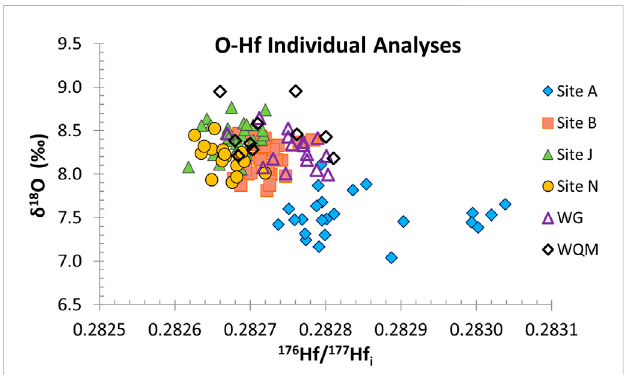
FIGURE 6 The paired δ 18 O and 176 Hf/ 177 Hf data of the zircons from sample Sites A, B, J and N of the Middledale Gabbroic Diorite and from the Woodlands Granite (WG) and the Windover Quartz Monzodiorite (WQM). It is clear that some correlation between the O and Hf isotope compositions exist at the inter-sample scale (Spearman Rank Correlation Coef fi cient, SRCC, of − 0.46 +0.15/-0.13, 95% con fi dence), and within some samples (WG, SRCC = − 0.39 +0.52/ − 0.35; Site N, SRCC = − 0.59 +0.44/ − 0.24) but not all. Note how most samples, with the single exception of the fi ne-grained sample from Site A, cluster in O-Hf isotope space. Data from Iles (2012) and Iles et al. (2015), and provided in Supplementary